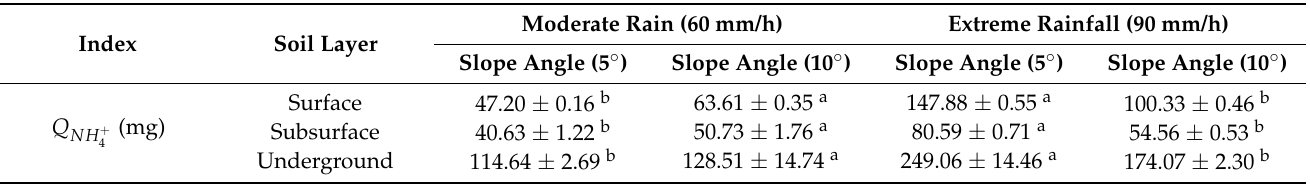
Figure 5. Variation of ammonium nitrogen output concentration through water flow in Karst slope farmland with time. Table 4. Output of ammonium nitrogen per hour on sloping farmland per square meter.